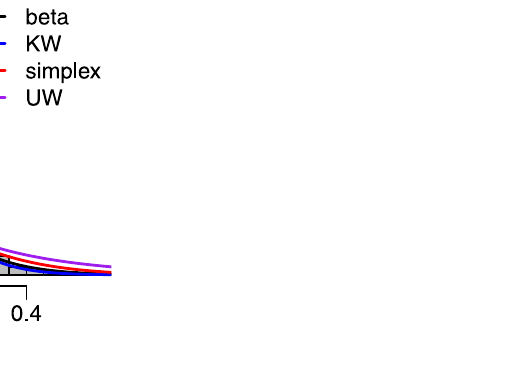
Fig 11. Histogram and fitted densities, period